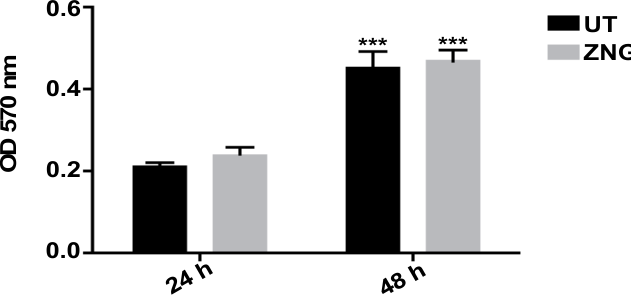
Figure 9. Analysis of cell viability, measured by the thiazolyl blue tetrazolium bromide (MTT) assay, of HaCaT cells grown on ZNGs coated glass for 24 and 48 h. Data are expressed as mean ± SD. Statistical analysis was performed by one-way analysis of variance (ANOVA) method coupled with the Bonferroni post-test (*** p < 0.001 compared to the untreated sample (UT)).